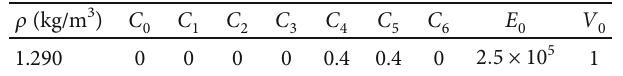
Table 8: Air parameters.